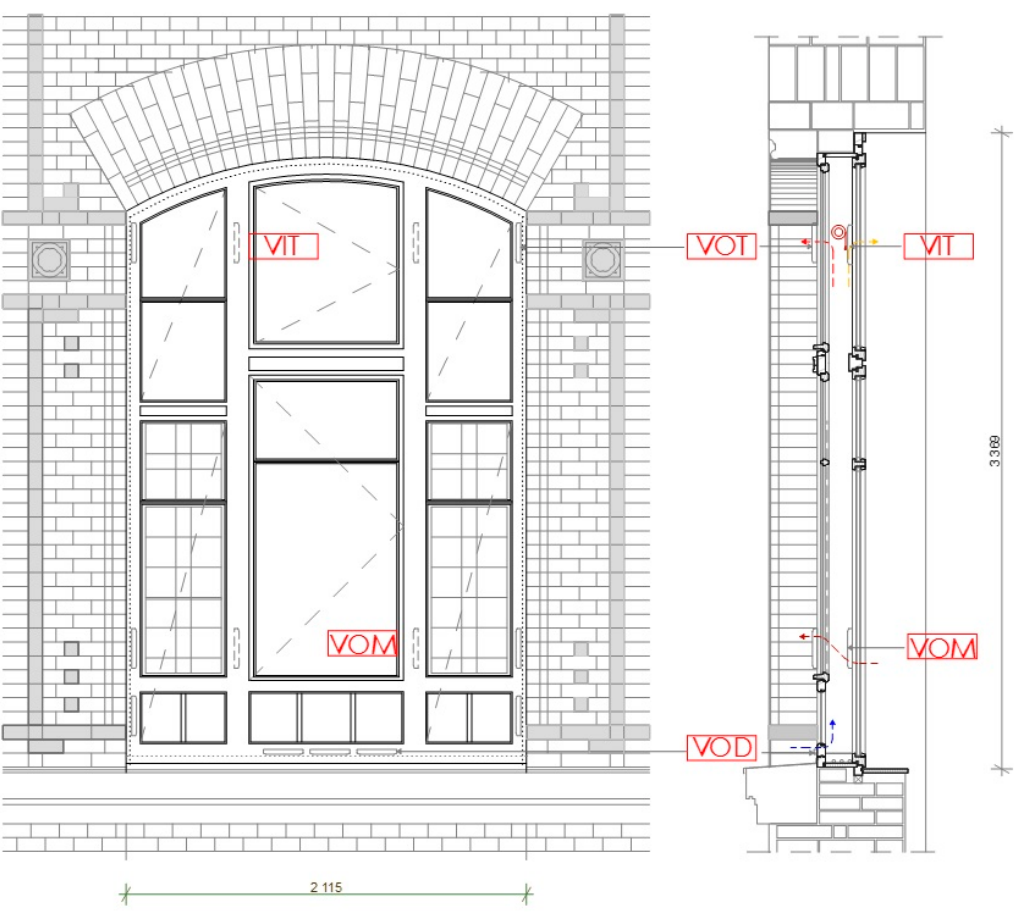
Figure 8. Position of controlled units of the designed window. Ventilation to Outside Down (VOD), Ventilation to Inside Top (VIT), Ventilation Outside Middle (VOM), and Ventilation to Outside Top (VOT).